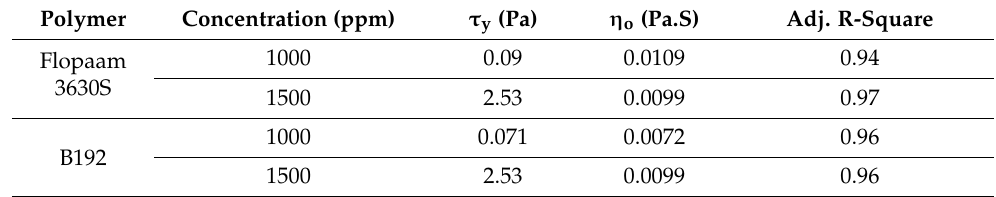
Table 3. Parameter values of samples using Bingham model.